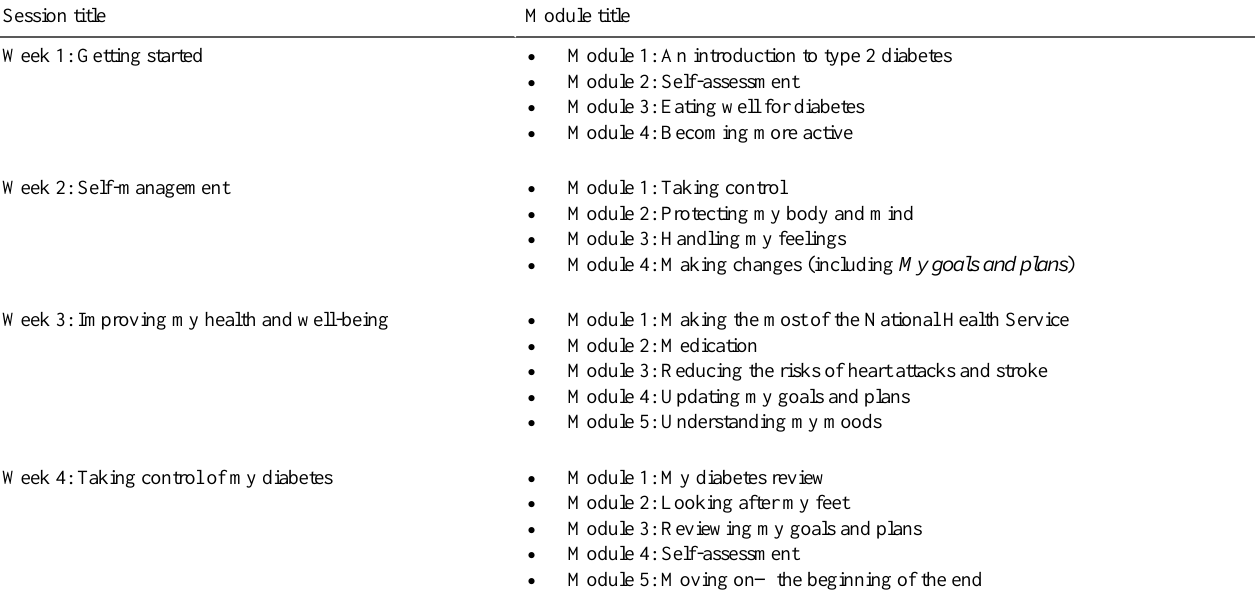
Table 1. Healthy Living for People with type 2 Diabetes: Starting Out program sessions and